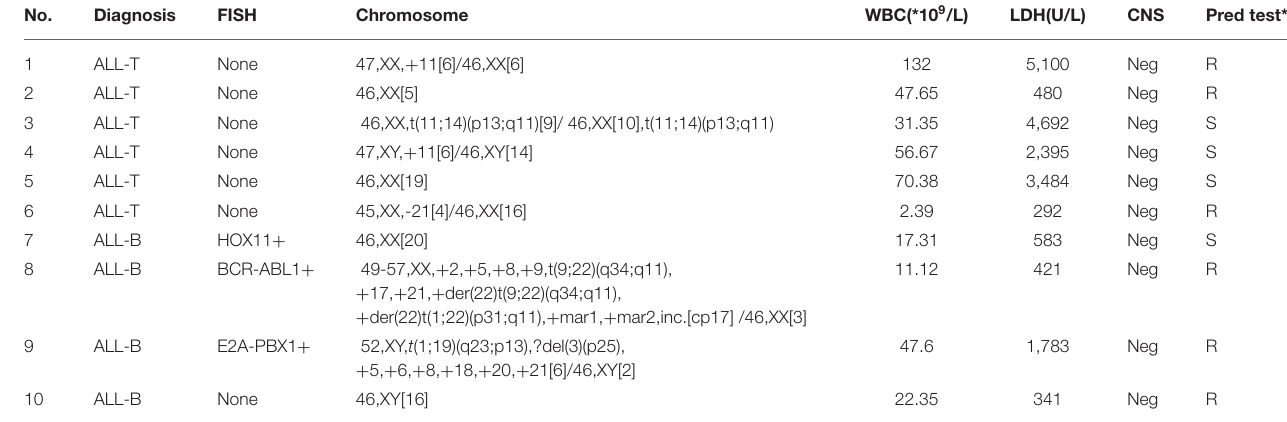
TABLE 3 | Clinical information from patients with NOTCH1 +